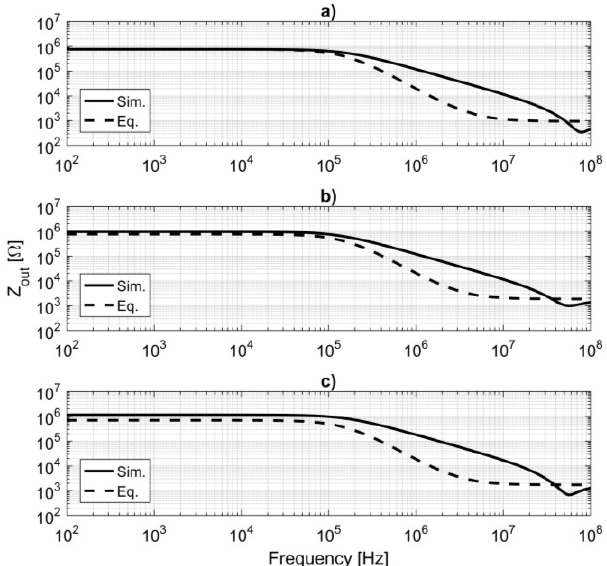
Fig.13: Simulated and calculated output impedance. a) QUAD b) DIF_C c) DIF_M